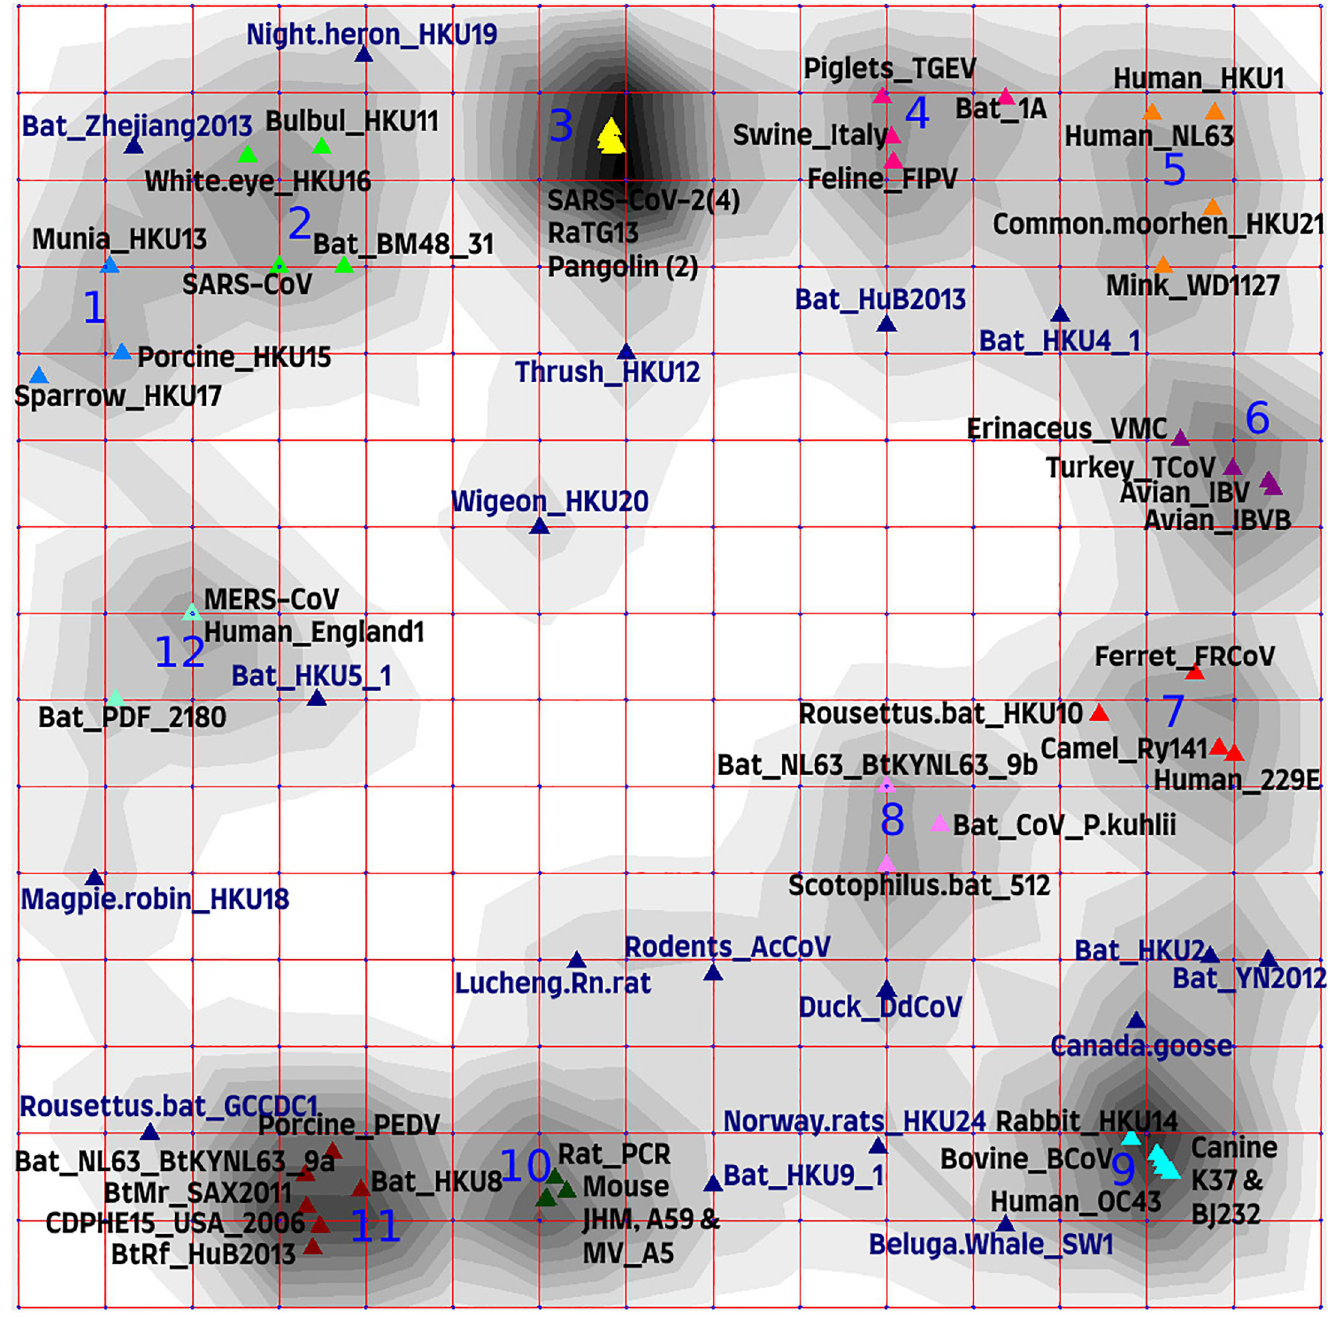
Fig 4. Elastic map of the 16 × 16 type in internal coordinates reflecting local density by shades of grey contours and demonstrating 69 coronavirus genomes depicted by differently colored triangle dots included in 12 clearly distinguished clusters (1–12); dark blue triangle dots depict unassigned genomes.